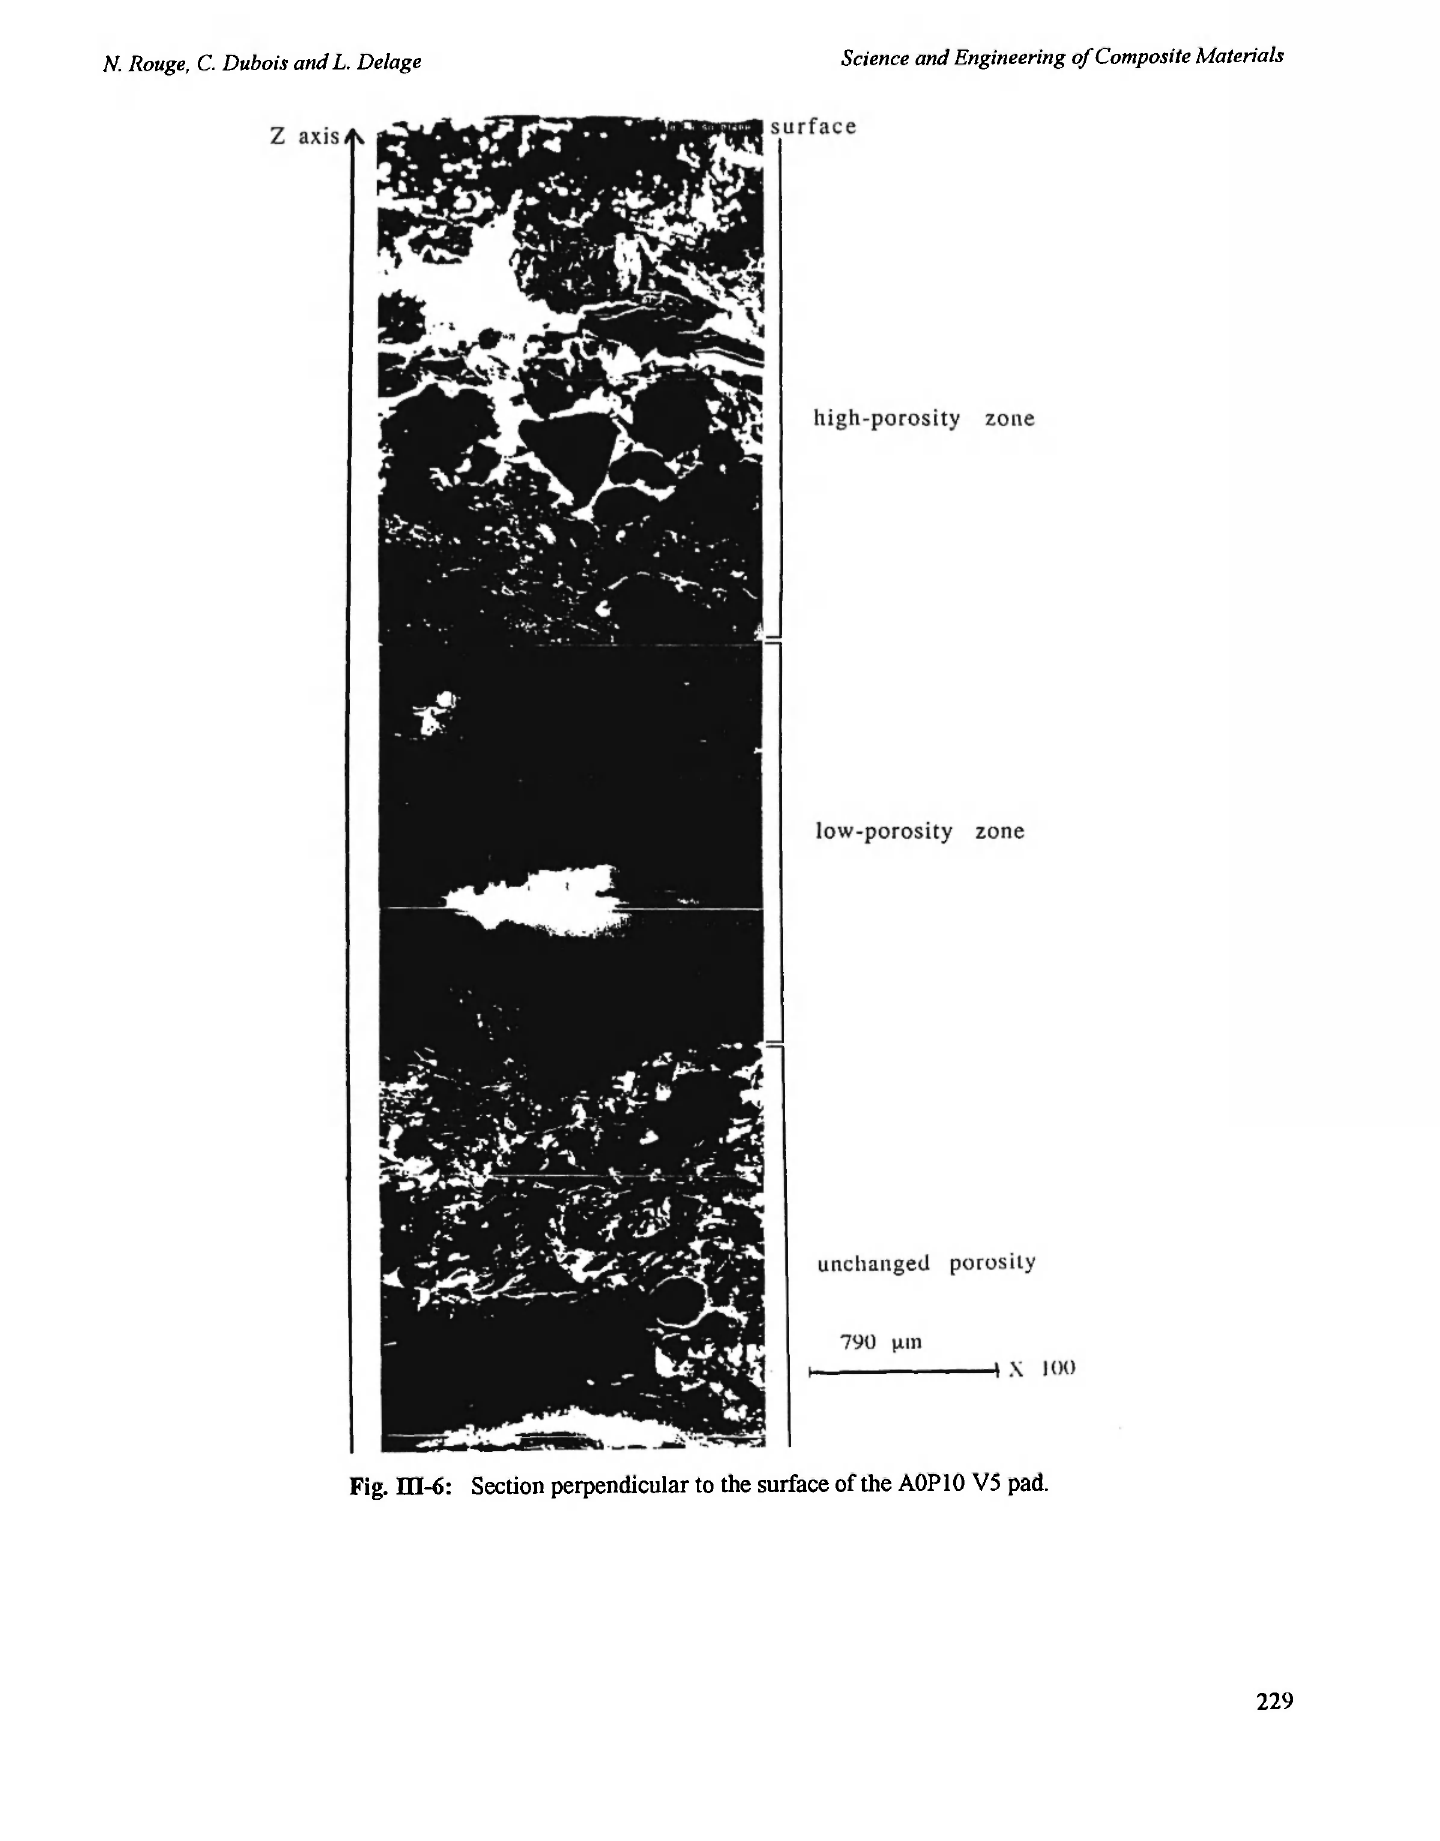
Fig. ΠΙ-6: Section perpendicular to the surface of the A0P10 V5